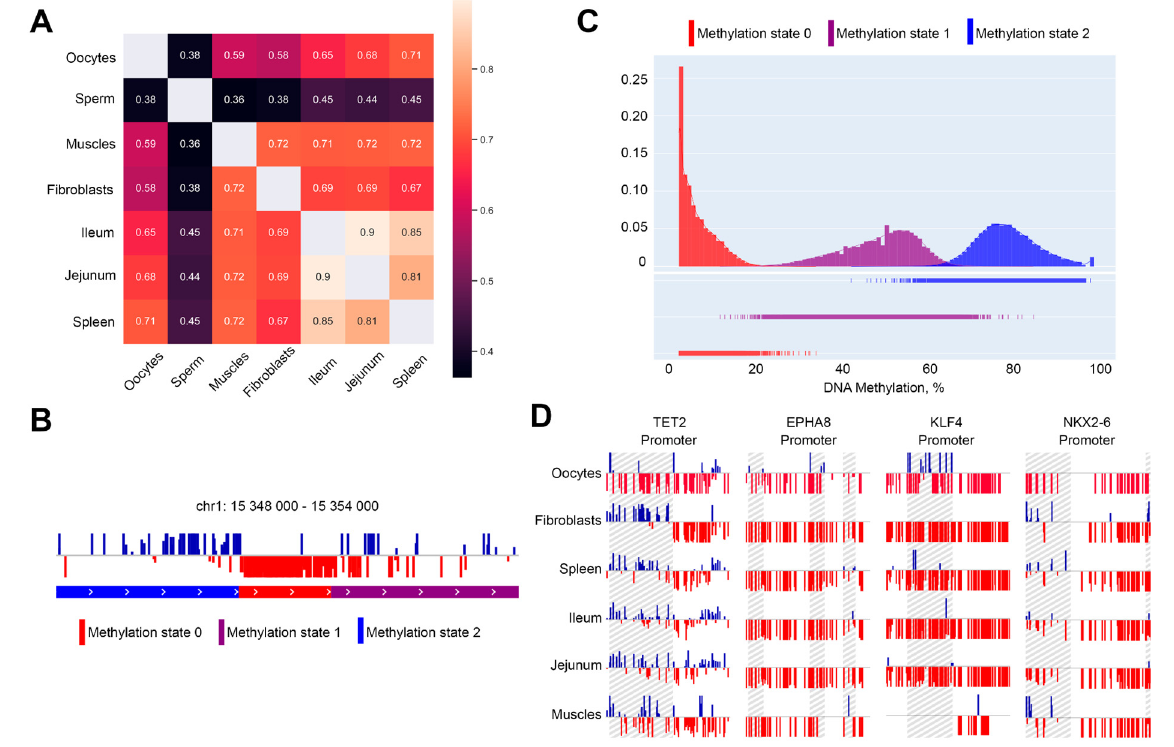
Figure 3. Identification of differentially methylated regions. ( A )—correlation between methylation features between different cell types. ( B )—example of methylation states calculated by Hidden Markov model. States 0, 1, 2 represent hypo-, intermediate- and hypermethylated regions. ( C )—distribution of different methylation states. ( D )—examples of differentially methylated regions within promoters identified using HMM. Differentially methylated regions are highlighted.